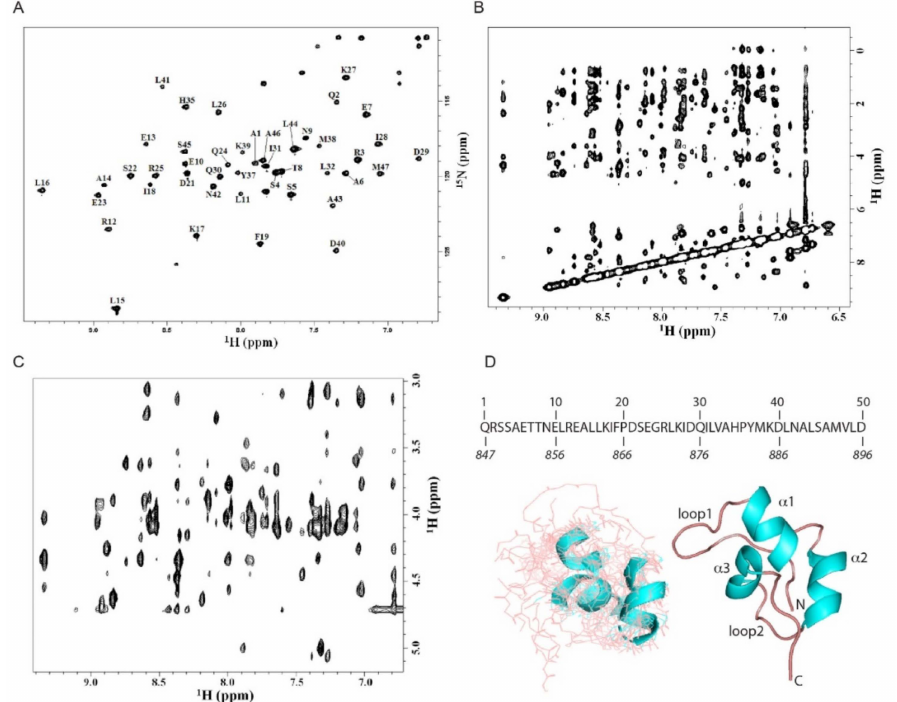
Figure 3. Structural model of the ubiquitin binding domains (UBD) domain of N4BP1. ( A ) 1 H- 15 N HSQC NMR spectrum of N4BP1 obtained as reported in Materials and Methods. The sequence of the structured region is shown with the relative numbering herein adopted. The numbering of residues referred to the full-length protein is shown in italics at the bottom. ( B ) Amide proton region of the 1 H- 1 H NOESY spectrum of N4BP1. ( C ) Finger print region of the 1 H- 1 H NOESY spectrum of N4BP1. ( D ) (Left) Cluster of the top 10 structures (out of 200) obtained by simulated annealing from NMR data of N4BP1. (Right) Cartoon representation showing the secondary structure of